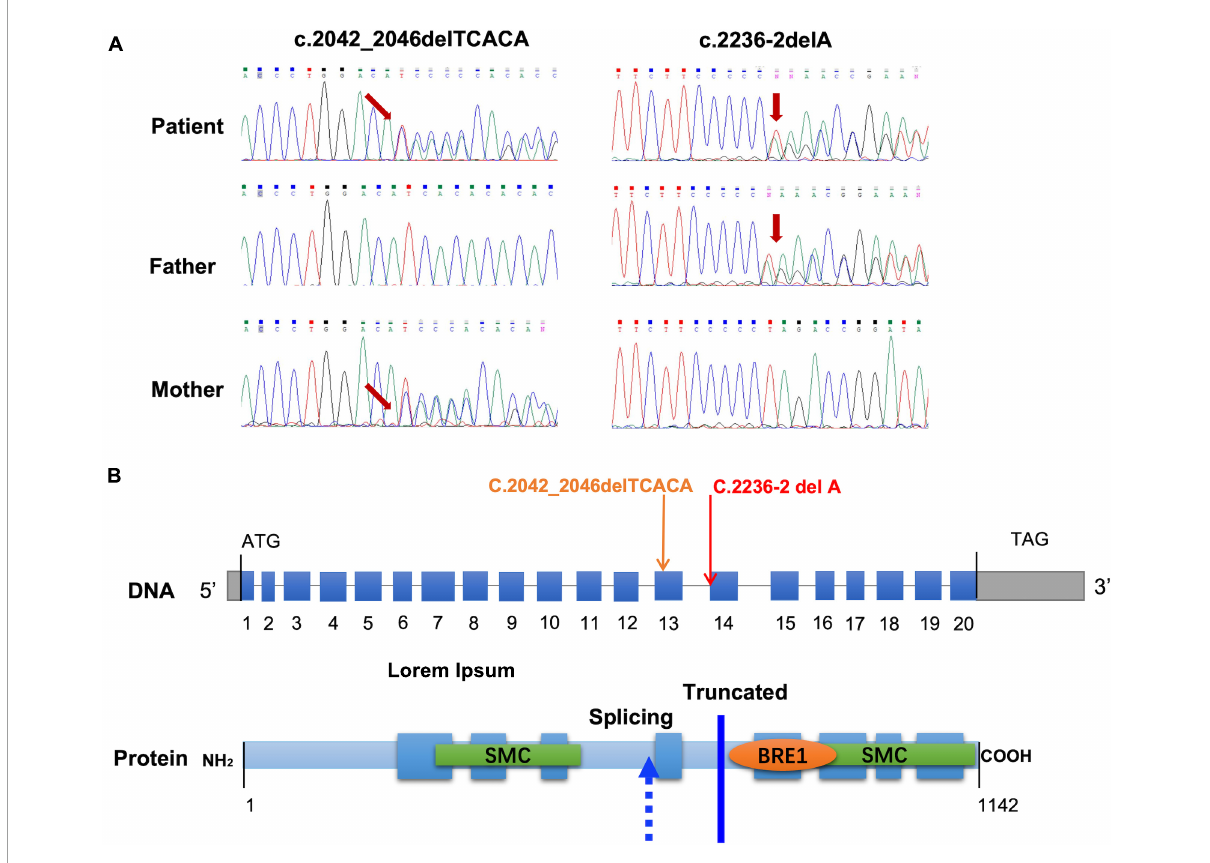
FIGURE2 Identification and analysis of mutations in the CCDC40 gene. (A) Sanger sequencing chromatogram of the mutations in CCDC40 from the patient and the parents of the patient. (B) Location of the mutations at the nucleotide and protein level. The blue boxes represent the 20 coding exons and the gray boxes represent 5 (cid:48) and 3 (cid:48) untranslated